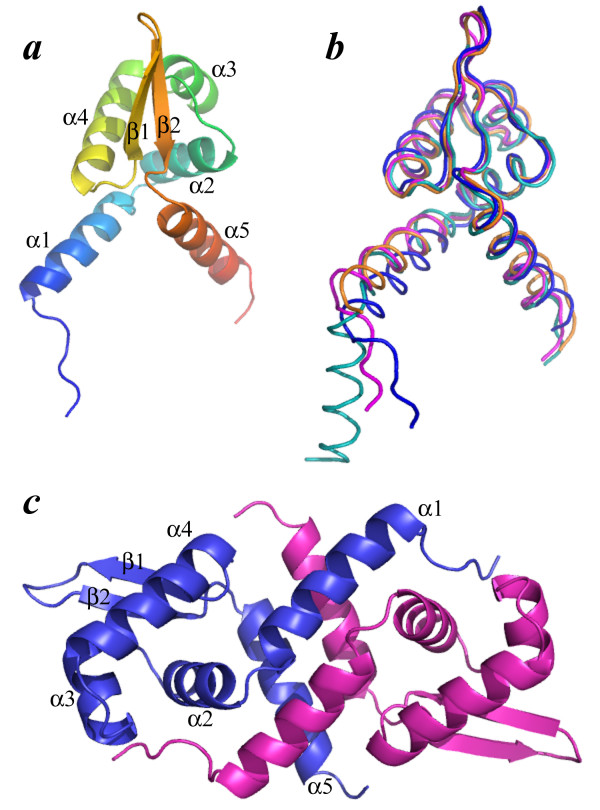
Three-dimensional structure of Vc-HlyU. (a) Cartoon diagram of Vc-HlyU monomer showing the α1-α2-α3-α4-β1-β2-α5 fold. (b) Superimposition of Synechococcus SmtB (blue color), S. aureus CzrA (orange), S. aureus CadC (teal), and Vc-HlyU (magenta) monomers. (c) Ribbon diagram of Vc-HlyU dimer showing the secondary structural units. Monomer A and B are in magenta and blue colors, respectively. All figures were created with PyMOL [73].